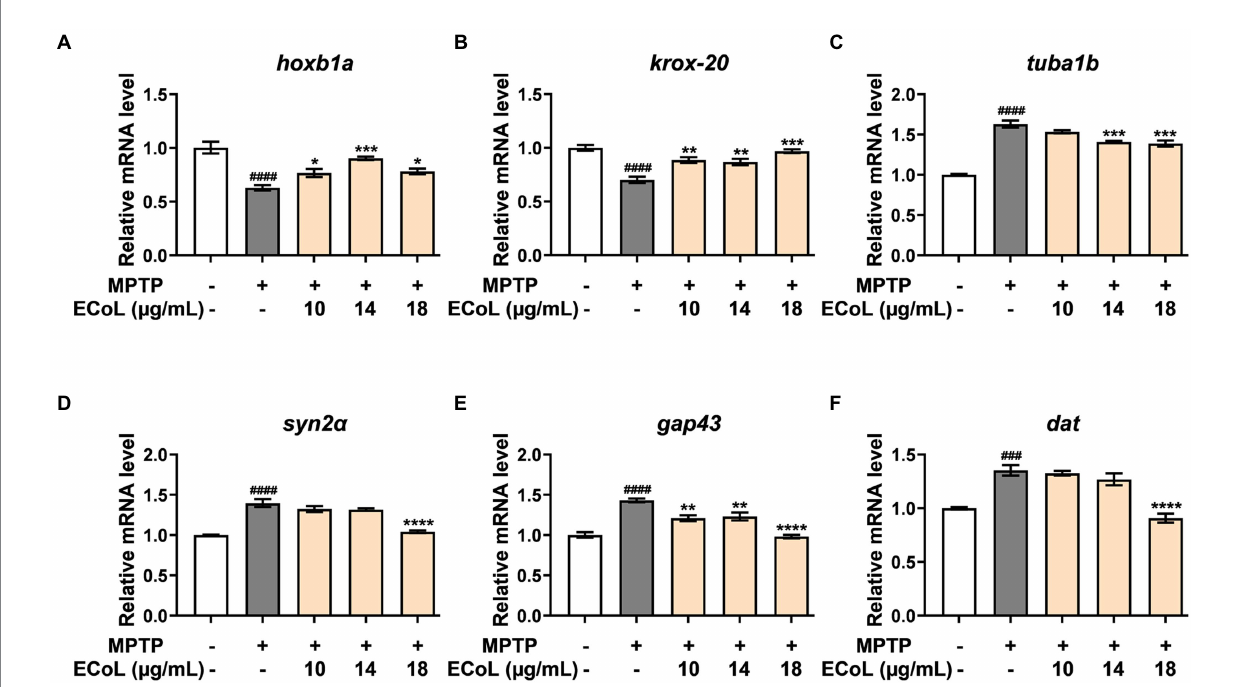
FIGURE 6 The mRNA expression levels of genes related to neurodevelopment. The expressions of hoxb1a (A) , krox-20 (B) , tuba1b (C) , s yn2 α (D) , gap43 (E) , and dat (F) after ECoL co-treatments. Data were represented as mean ± SEM, n = 3, and statistically analyzed by one-way ANOVA followed by Duncan test. ### p < 0.001, #### p < 0.0001 vs. control; *p < 0.05, **p < 0.01, ***p < 0.001, ****p < 0.0001 vs.